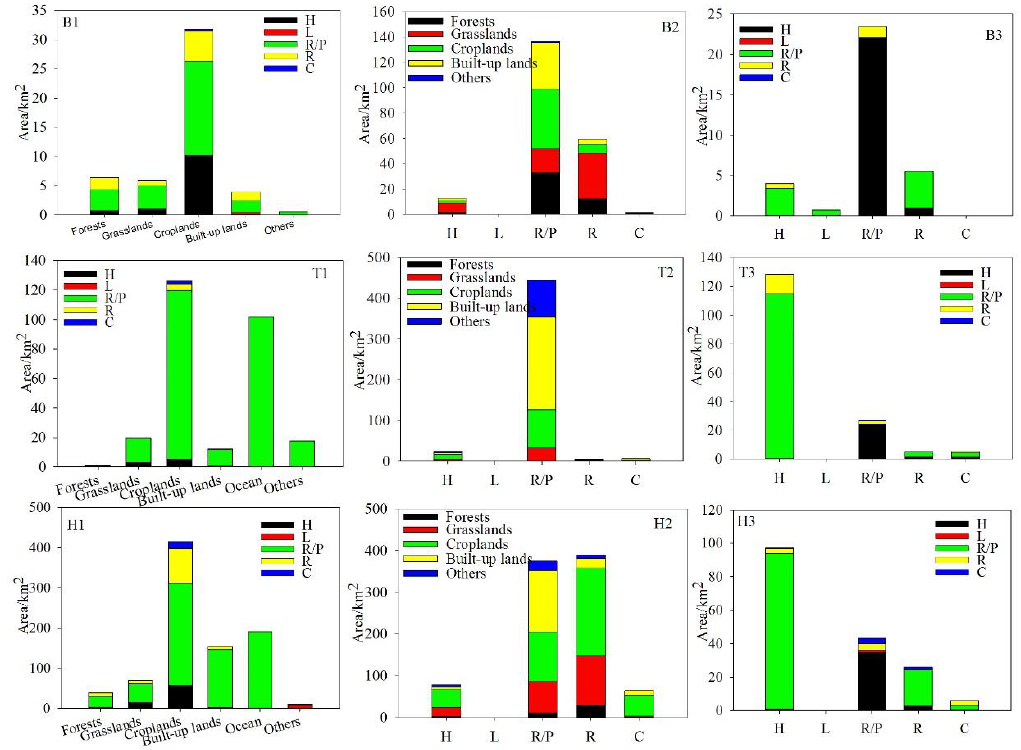
Figure 5. Modes of spatial wetland transformation. Note: B = Beijing; H = Hebei; T = Tianjin; 1 = wetlands-in (other land-use types converted into wetlands); 2 = wetlands-out (wetlands converted into other land-use types); and 3 = wetlands-internal (conversion between